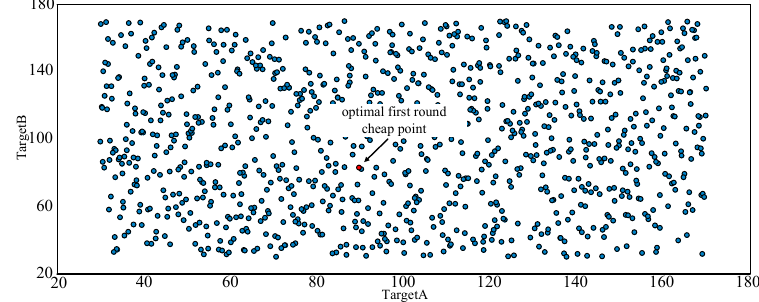
Figure 12. First round cheap points.